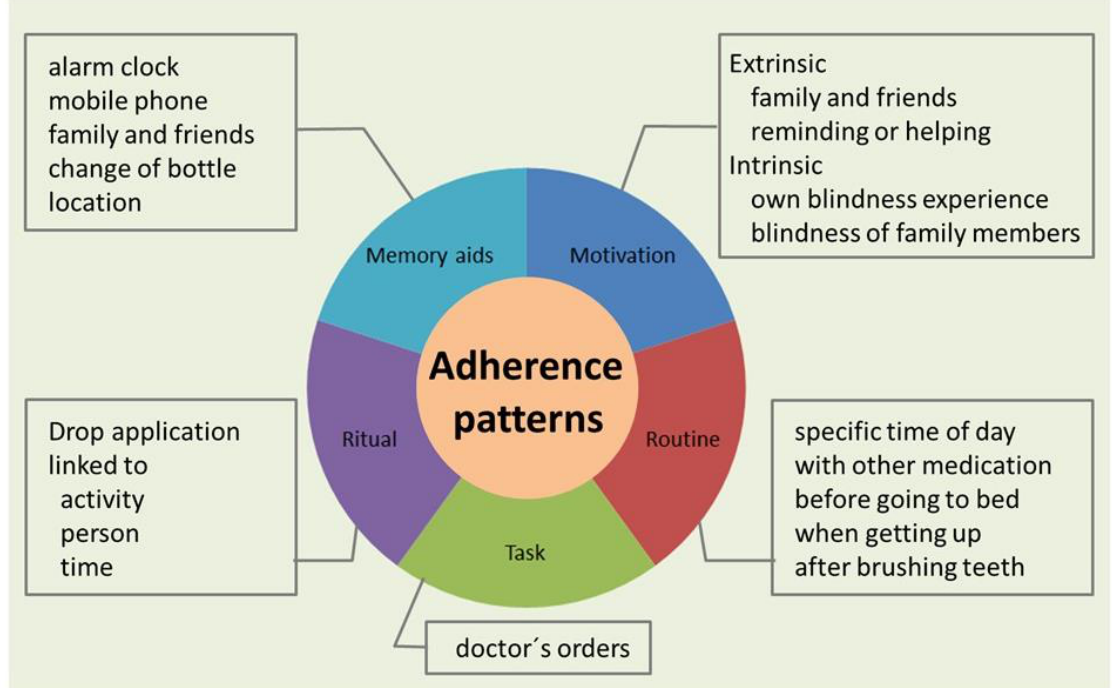
Figure 1. Identified patterns of adherence. The patterns are linked to specific actions or behaviors of people, which helps them to apply eye drop medication regularly.